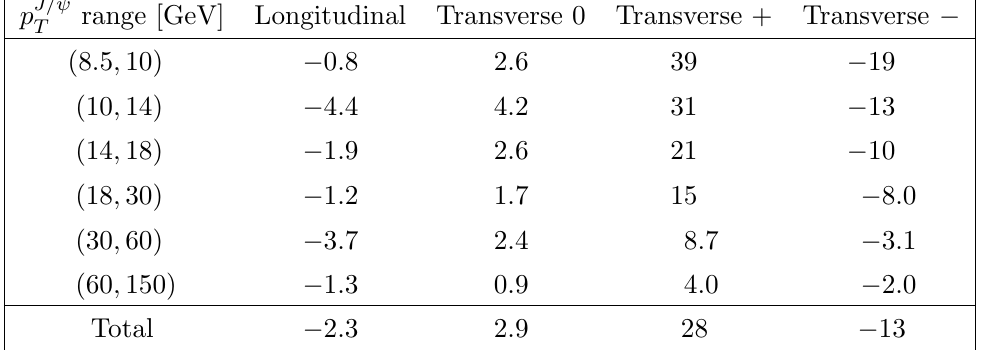
Table 6. Percentage variations on the di(cid:11)erential distribution for four extreme cases of J= spin alignment of maximal polarisation relative to the nominal unpolarised assumption for j y j < 2 : 1 J=